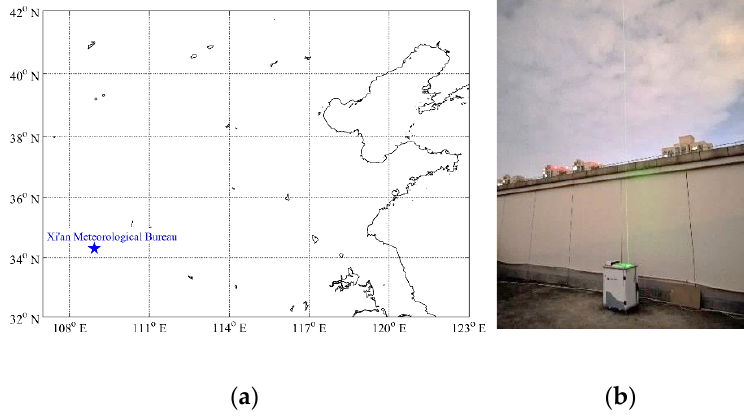
Figure 1. ( a ) Geographical location of Xi ’ an Meteorological Bureau; ( b ) The observation figure of P-MPL (polarized micropulse lidar) at Xi ’ an Meteorological Bureau.